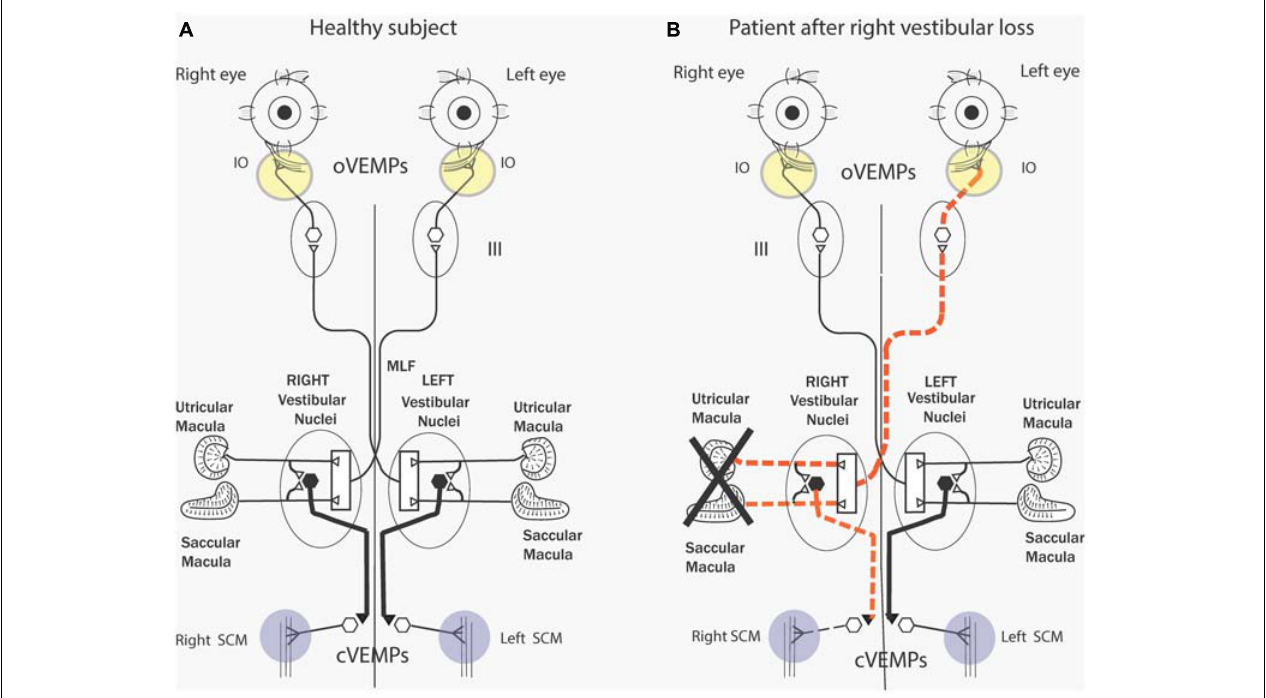
FIGURE 2 | (A) Simplified schematic diagram of some of the known neural vestibulo-ocular and vestibulo-collic projections that underlie the oVEMP and cVEMP myogenic responses. The Figure is based on known anatomical projections (Uchino and Kushiro, 2011) and on physiological results that high-frequency electrical stimulation of the utricular nerve results in the activation of the contralateral inferior oblique (IO) (Suzuki et al., 1969). Electrodes beneath the eyes record the oVEMP as the person looks up. Afferents from the saccular and utricular macula project to the vestibular nuclei, but the exact termination of these afferents with the nucleus is still unclear so this figure represents the present uncertainty about the exact neural connections of these afferents within the nuclei as an open box. The projections of the saccular macula in the inferior vestibular nerve, synapsing on an inhibitory neuron in the vestibular nucleus ( thick black lines ), projecting to spinal motoneurons controlling the sternocleidomastoid muscle (SCM), are established (Uchino and Kushiro, 2011). Electrodes over contracted SCM muscles record the cVEMP. Unilateral vestibular loss (B) has been shown to result in reduced or absent contralateral oVEMP n10 and a reduced or absent ipsilateral cVEMP. Reproduced from Curthoys et al. (2011a) with permission from